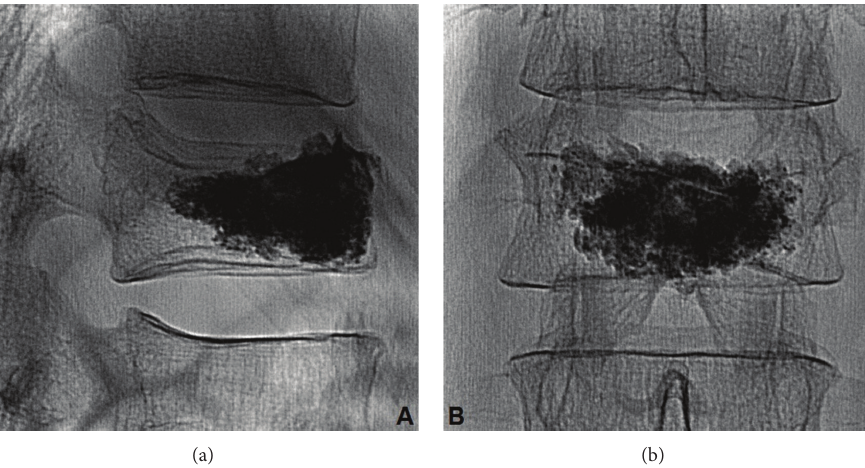
Figure 1: Lateral (a) and anteroposterior (b) end-procedure fluoroscopic views showing optimal cement spreading inside vertebral body; note the excellent opacity of the strontium-containing